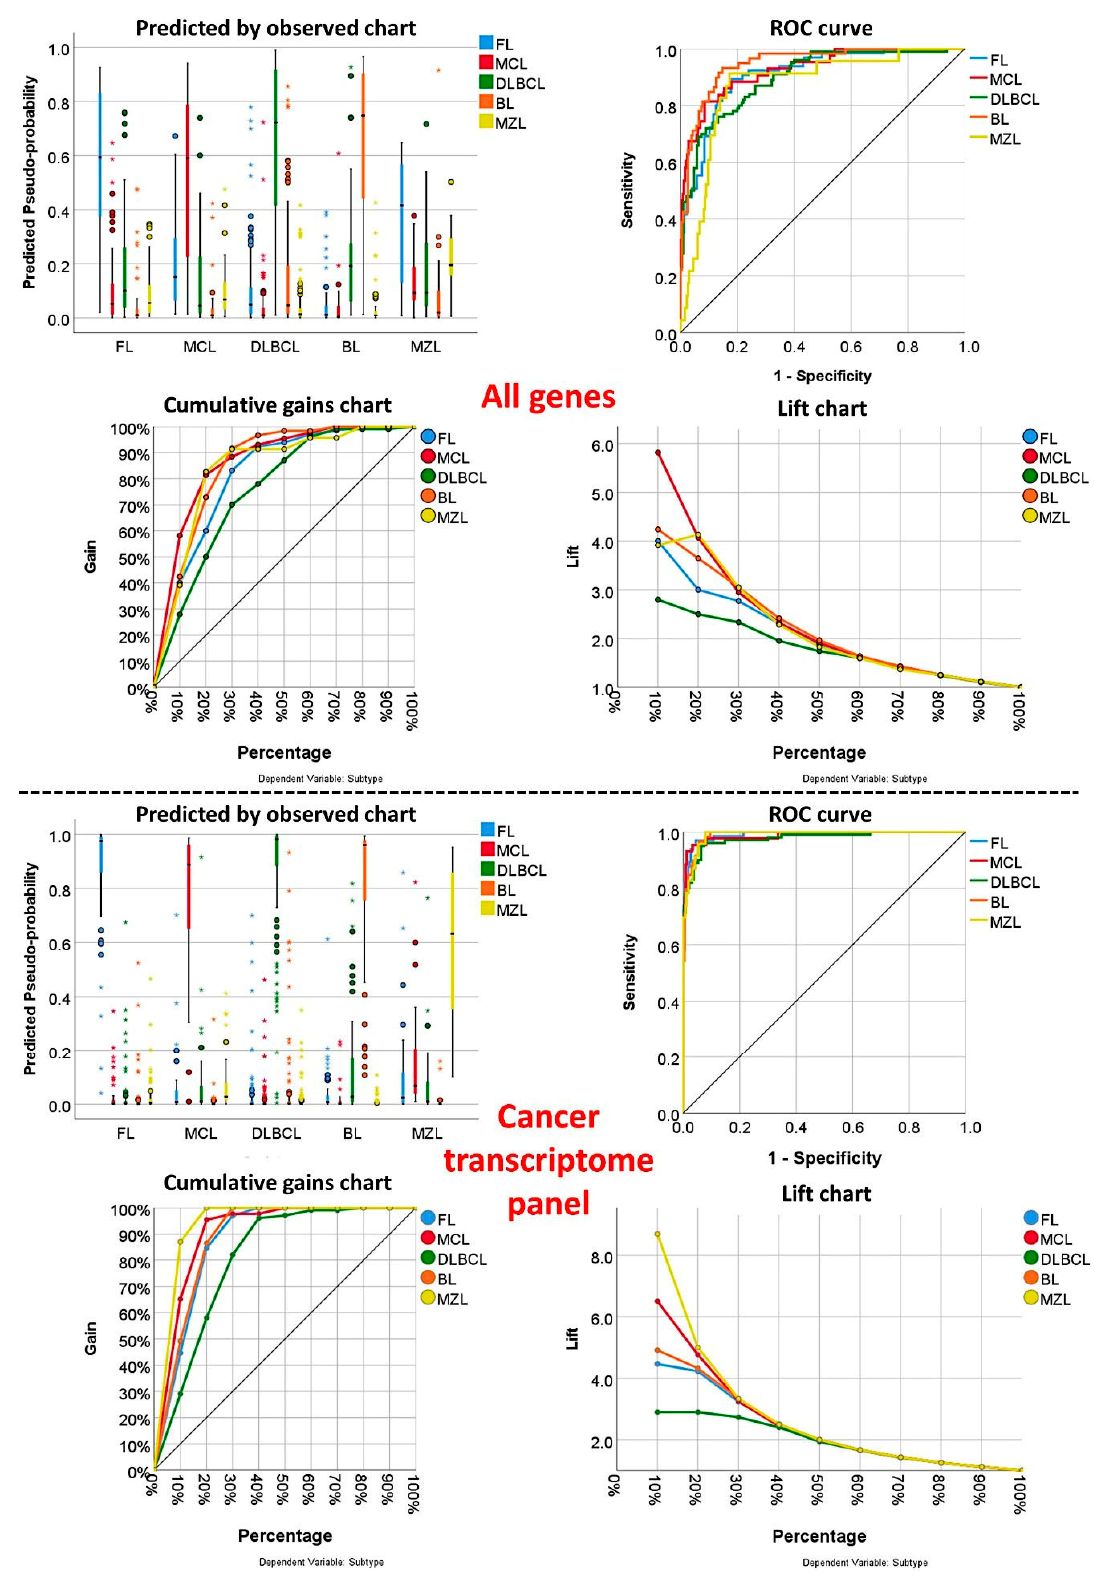
Figure 3. MLP analysis for predicting NHL subtypes based on all genes and cancer transcriptome panel. This figure shows the network performance of the MLP analyses. First, all the genes of the array were used as input. Second, the input data were the genes of the cancer transcriptome panel. In both cases, the output was the 5 NHL subtypes. As shown by the ROC curve, the performance was higher for the cancer transcriptome panel.